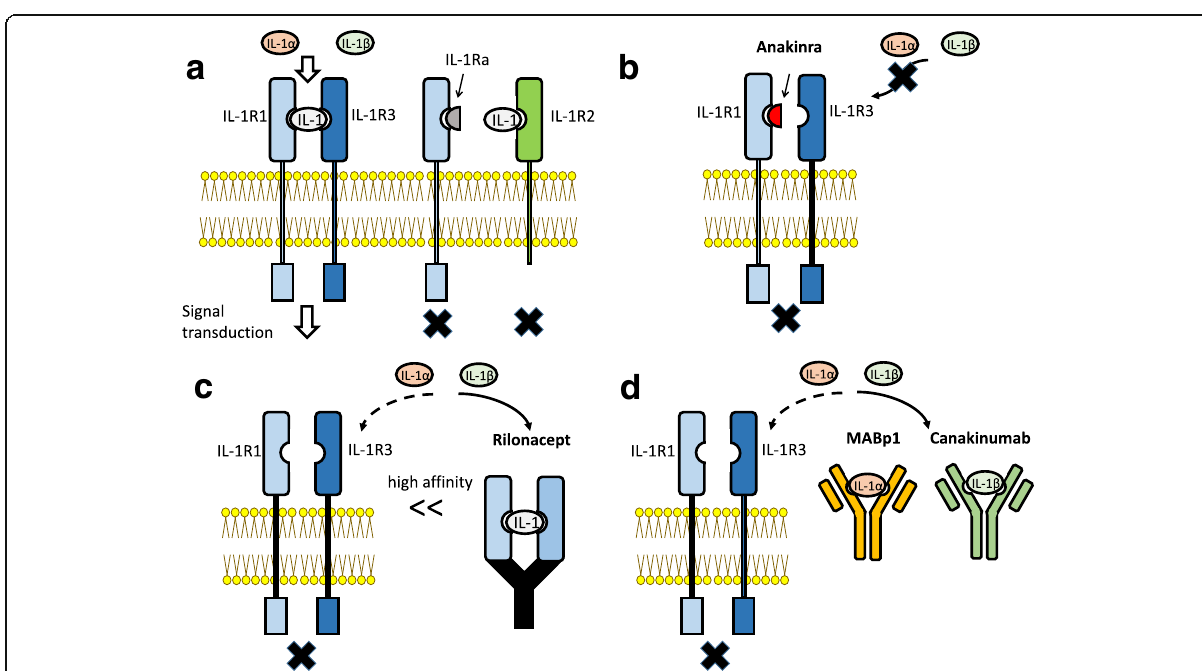
Fig. 1 Interleukin-1 receptors and inhibitors of IL-1 signaling. a IL-1R1 interacts with both IL-1 α and IL-1 β and promotes signal transduction, together with its co-receptor IL-1R3 (IL-1RAcP). IL-1Ra is a protein that binds to IL-1R1 but not IL-1R3, and it is as an inhibitor of IL-1 signaling. IL-1R2 is a decoy receptor because it lacks a cytoplasmic segment. b Anakinra is a recombinant form of intrinsic human IL-1Ra. It works as an antagonist of IL-1R1, and it is able to inhibit both IL-1 α and IL-1 β . c Rilonacept is a recombinant fusion protein including the extracellular protein of human IL-1R1 and IL-1R3 fused with the Fc portion of human IgG1. It binds to both IL-1 α and IL-1 β with high affinity and has a long-term inhibitory effect. d Canakinumab and MABp1 are monoclonal antibodies against IL-1 β and IL-1 α , respectively. They bind to and neutralize their targets